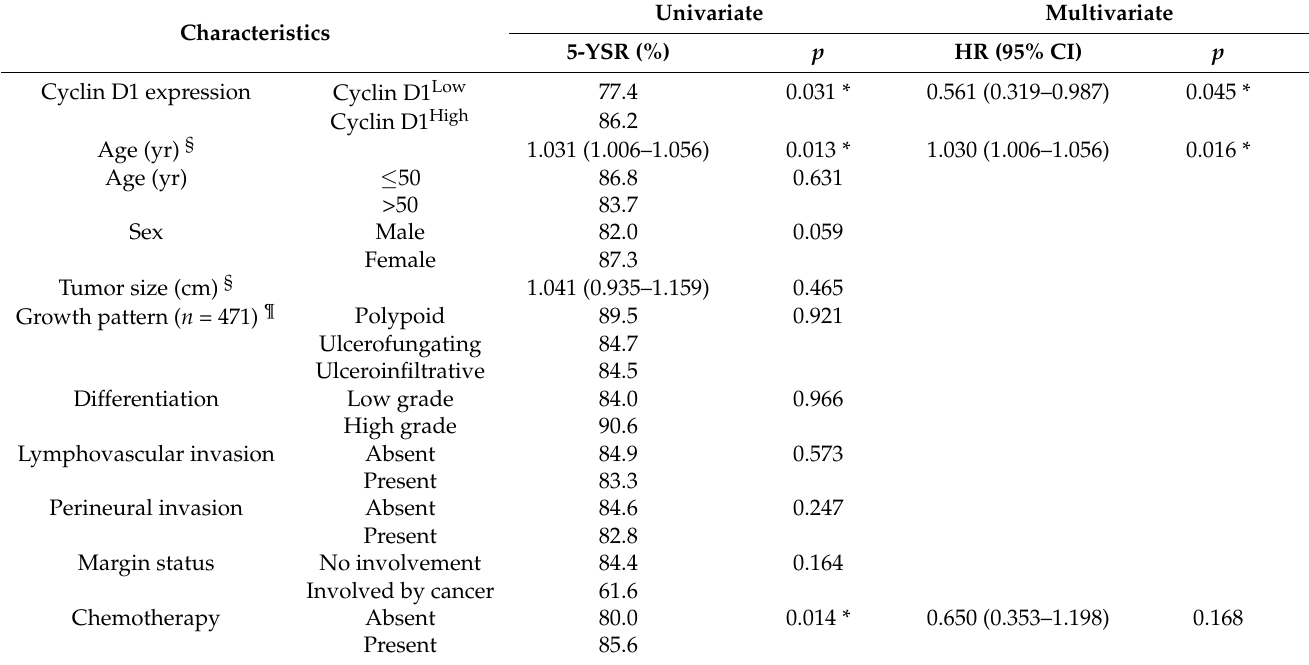
Table 3. Association between clinicopathological factors and OS in 495 patients with CRC.